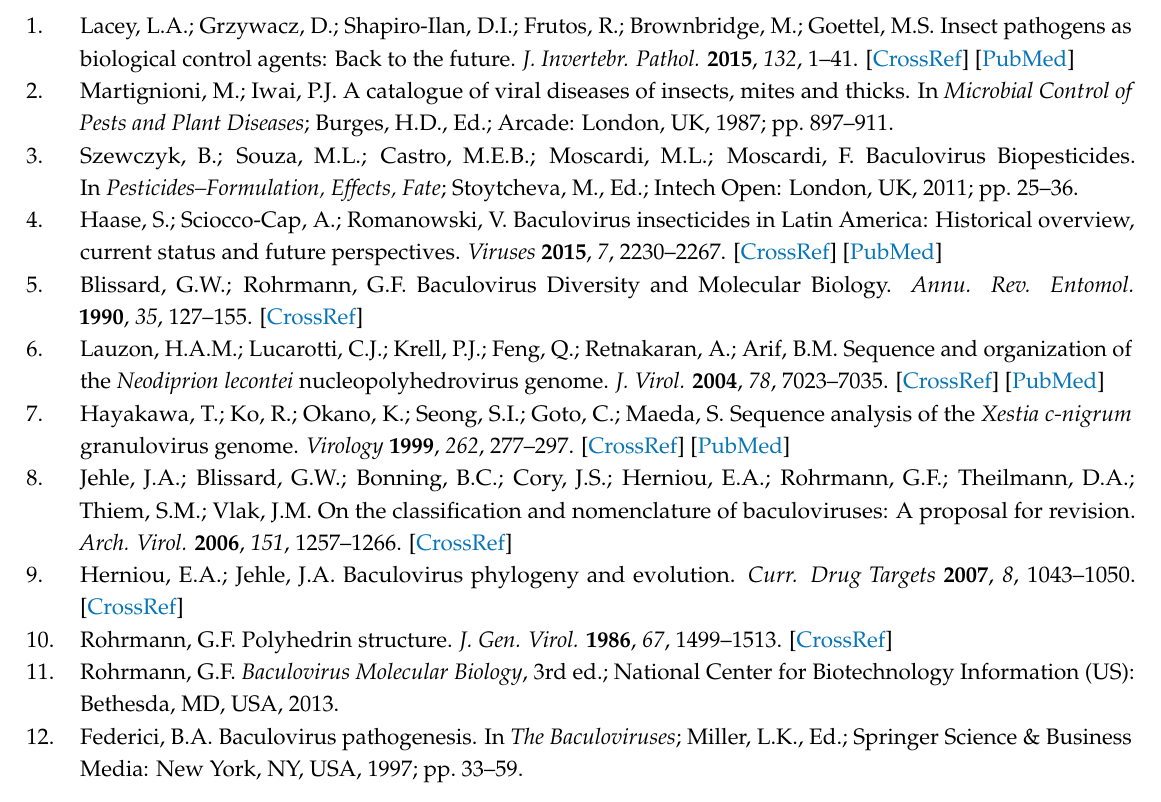
Table S1: The absolute values from the Tm difference between each species (e.g., AdorGV Tm gran compared with AgseGV Tm gran ). Figure S1: The amino acid sequence alignments of predicted PCR products with primers: (a) gran , (b) lef-8 , and (c) lef-9 . 1–8 are the representative group in this study, 9–24 are all the remaining